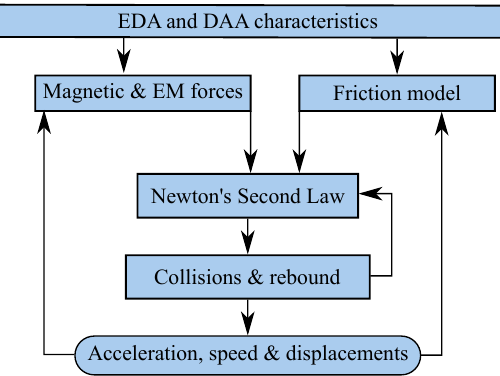
Figure 5. Flowchart of the dynamic model.